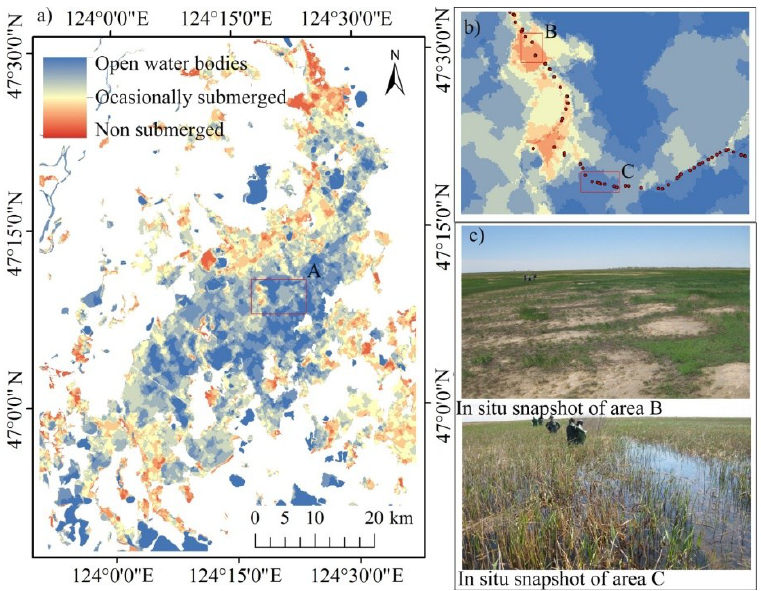
Figure 5. ( a ) The flooding frequency map; and ( b ) the zoomed-in area of A; ( c ) an in situ snapshot of the area B and C in 2015-05-15.